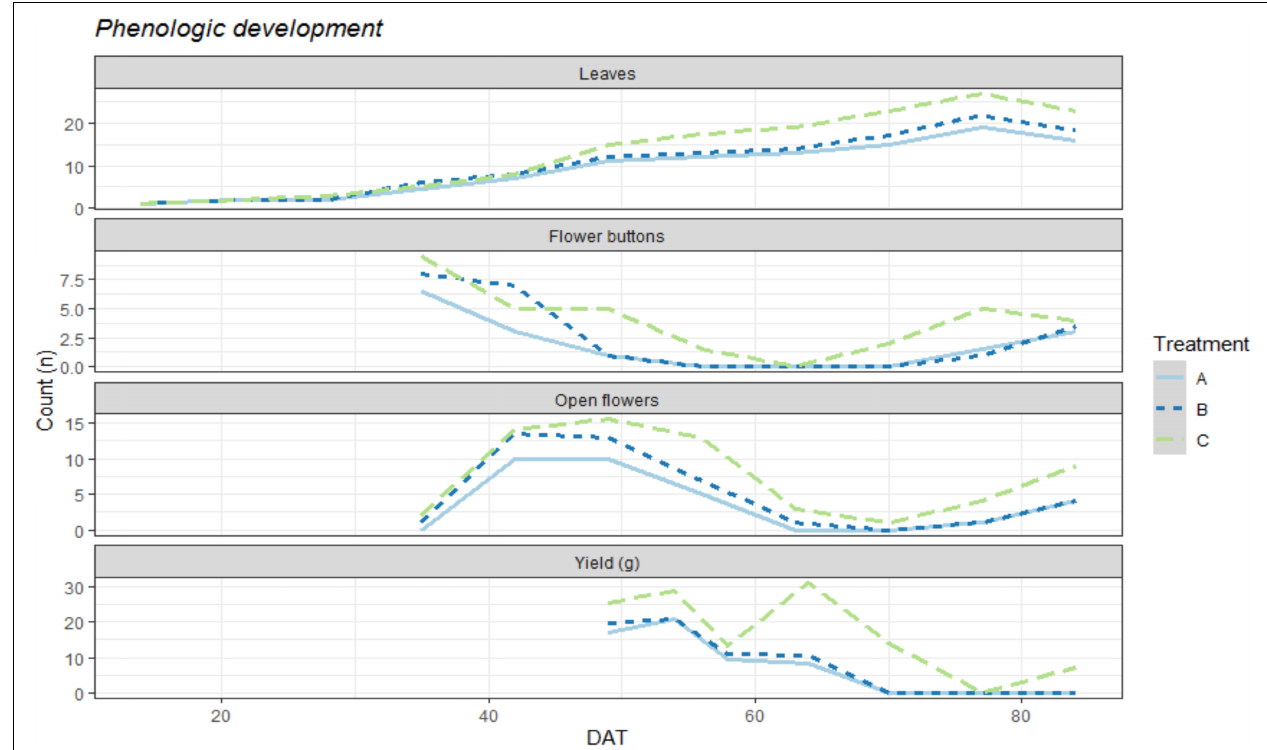
FIGURE 1 | Graphic representation of the mean numerical count per plant for each organ (Leaves, flower buttons, open flowers) and yield in g/plant on a weekly basis, DAT representing the days after transplanting inside the iRTG. The colors represent the three treatments: A = N.free solution with Rhizobium inoculation and 2g of struvite per plant. B = N.free solution with Rhizobium inoculation and 5g of struvite per plant. C = Complete nutrient solution without struvite and no inoculation treatment.